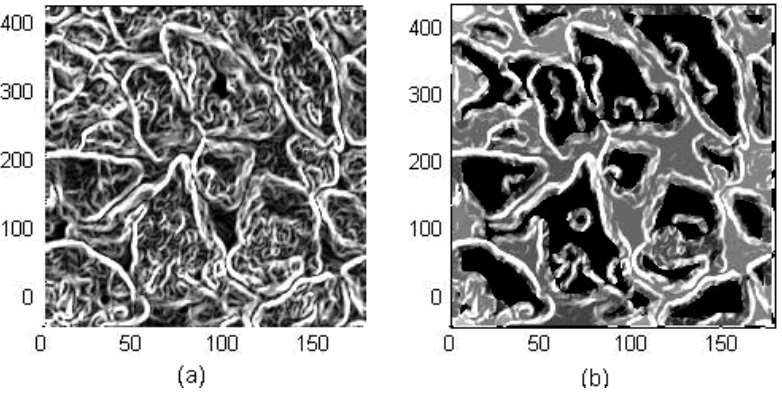
Figure 8. (a ) Sobel image; ( b ) image generated by